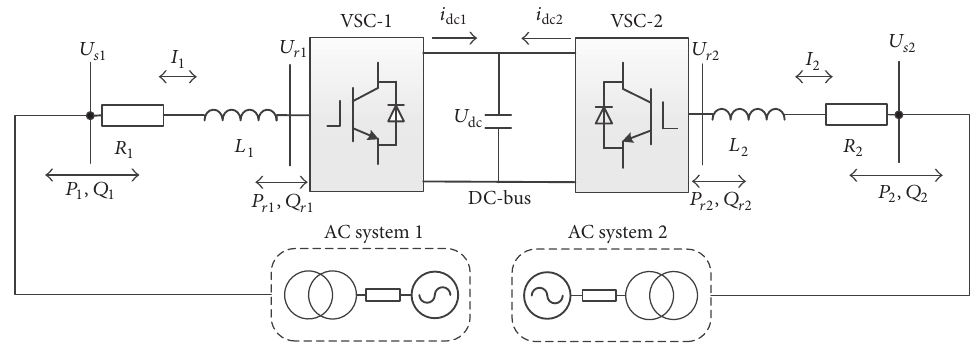
Figure 1: Equivalent physical model for BTB VSC-HVDC